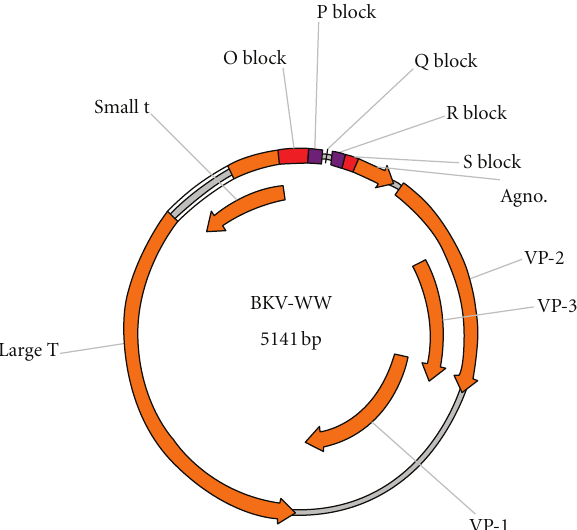
Figure 1: Diagram showing the archetypal wild type BK virus structure. The O, P, Q, and R blocks represent the noncontrol coding region